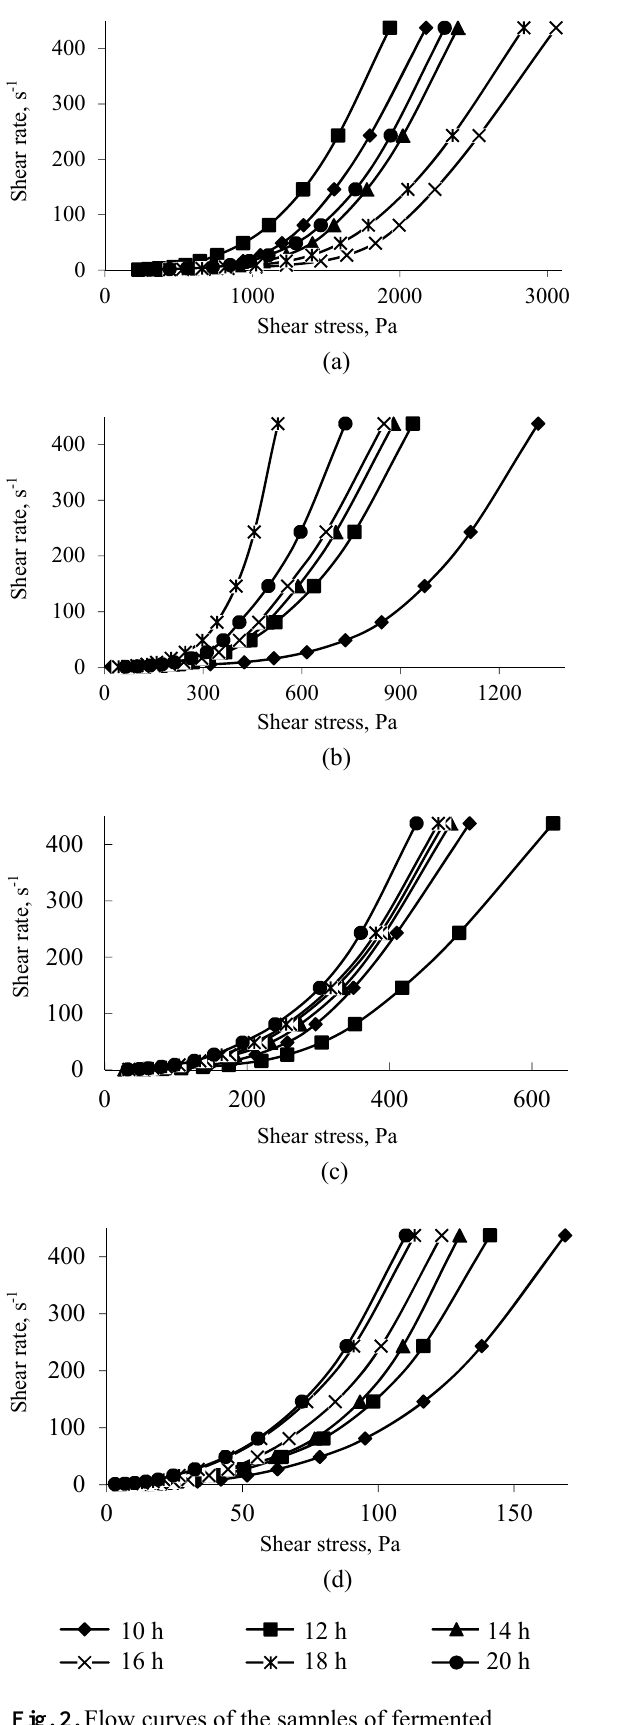
Fig. 2. Flow curves of the samples of fermented pregelatinized flour during fermentation with the addition of a starter in the amount of: (a) 4–20%, (b) 6–30%, (c) 8–40% and (d) 10–50%.